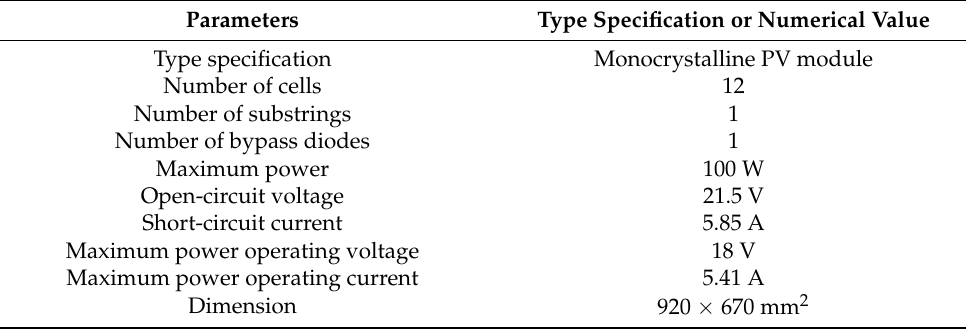
Table 1. The type and parameters of the experimental PV module. Parameters